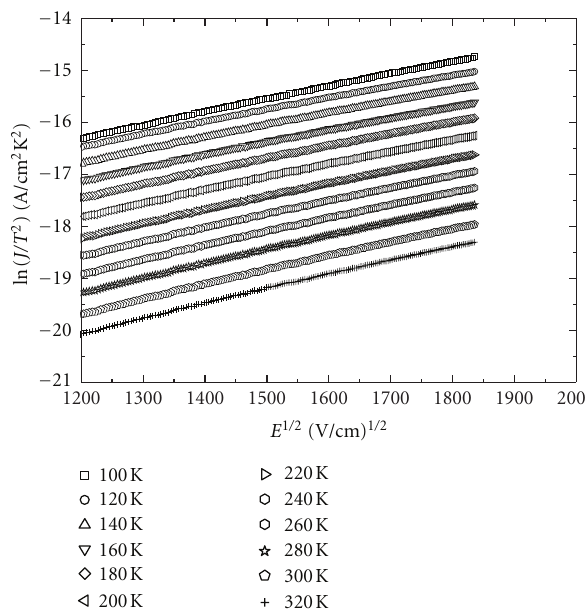
Figure 6: Characteristics of Schottky emission in the region of high field under gate injection.